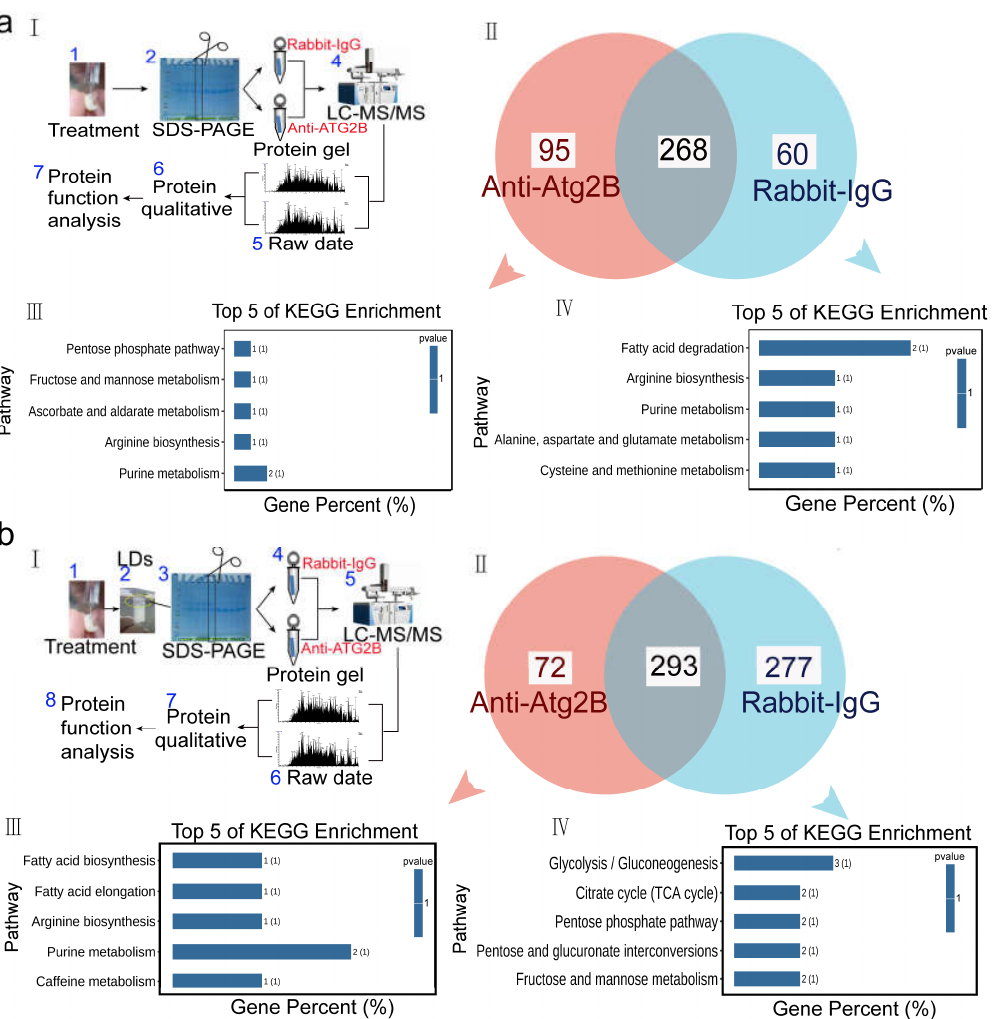
Figure 5. Changes of proteins expression after Anti-Atg2B antibody neutralization of Apis mellifera pupae. LC−MS/MS protein identification were conducted to analysis the whole body ( a ) or lipid droplet protein; ( b ) profiles between group IgG and Anti−Atg2B. ( Ⅰ ) Flow Chart of the LC−MS/MS protein identification; ( Ⅱ ) Venn diagram analysis of the identified proteins; KEGG enrichment analysis was performed after comparison analysis of the identified proteins in group Anti-Atg2B ( Ⅲ ) and IgG ( Ⅳ ).